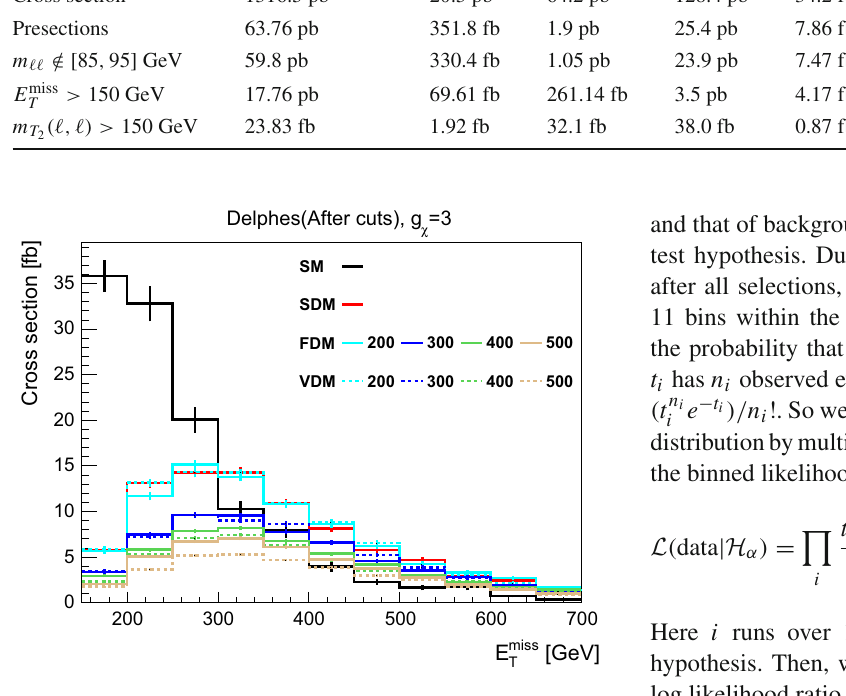
Fig. 5 Distributions of E miss for signal and SM background events T after applying all selection requirements. The distribution for back- ground events is normalized to the actual cross section and those for signals have been 100 times magnified for